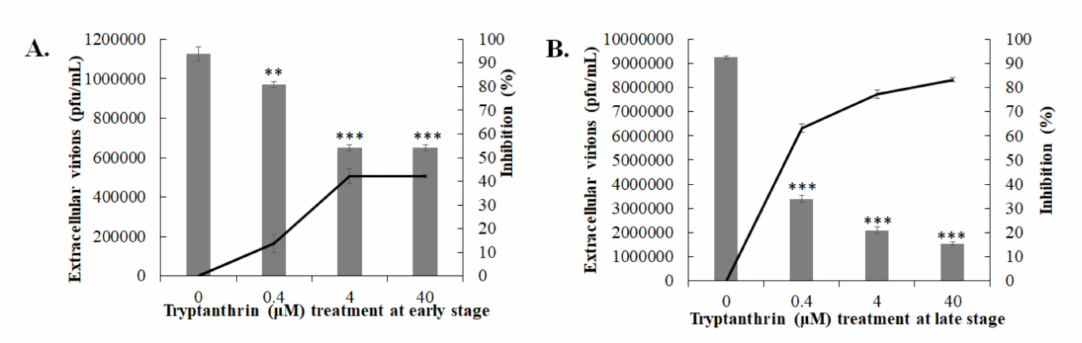
Figure 7. Time-of-addition and removal assay for examining the e ff ect of tryptanthrin on the early and late stages of HCoV-NL63 replication. The cell monolayer was infected with HCoV-NL63 and treated with tryptanthrin simultaneously ( A , early stage), or 1 hpi ( B , late stage). After 2 h of incubation, the virus / tryptanthrin mixture was removed; the cell monolayer was washed with PBS and cultured for an additional 36 h with incubation at 37 ◦ C. The extracellular virus yield in the supernatant was determined using the plaque assay; the inhibition rate was analyzed based on the loss in the ratio of virus titer in treated group to that in the mock-treated group. **, p value < 0.01; ***, p value < 0.001 compared with mock-treated infected